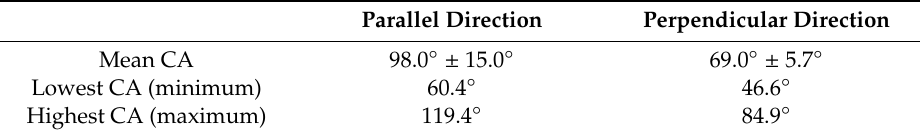
Table 2. Contact Angle (CA) of 3D printed PLA without treatment.